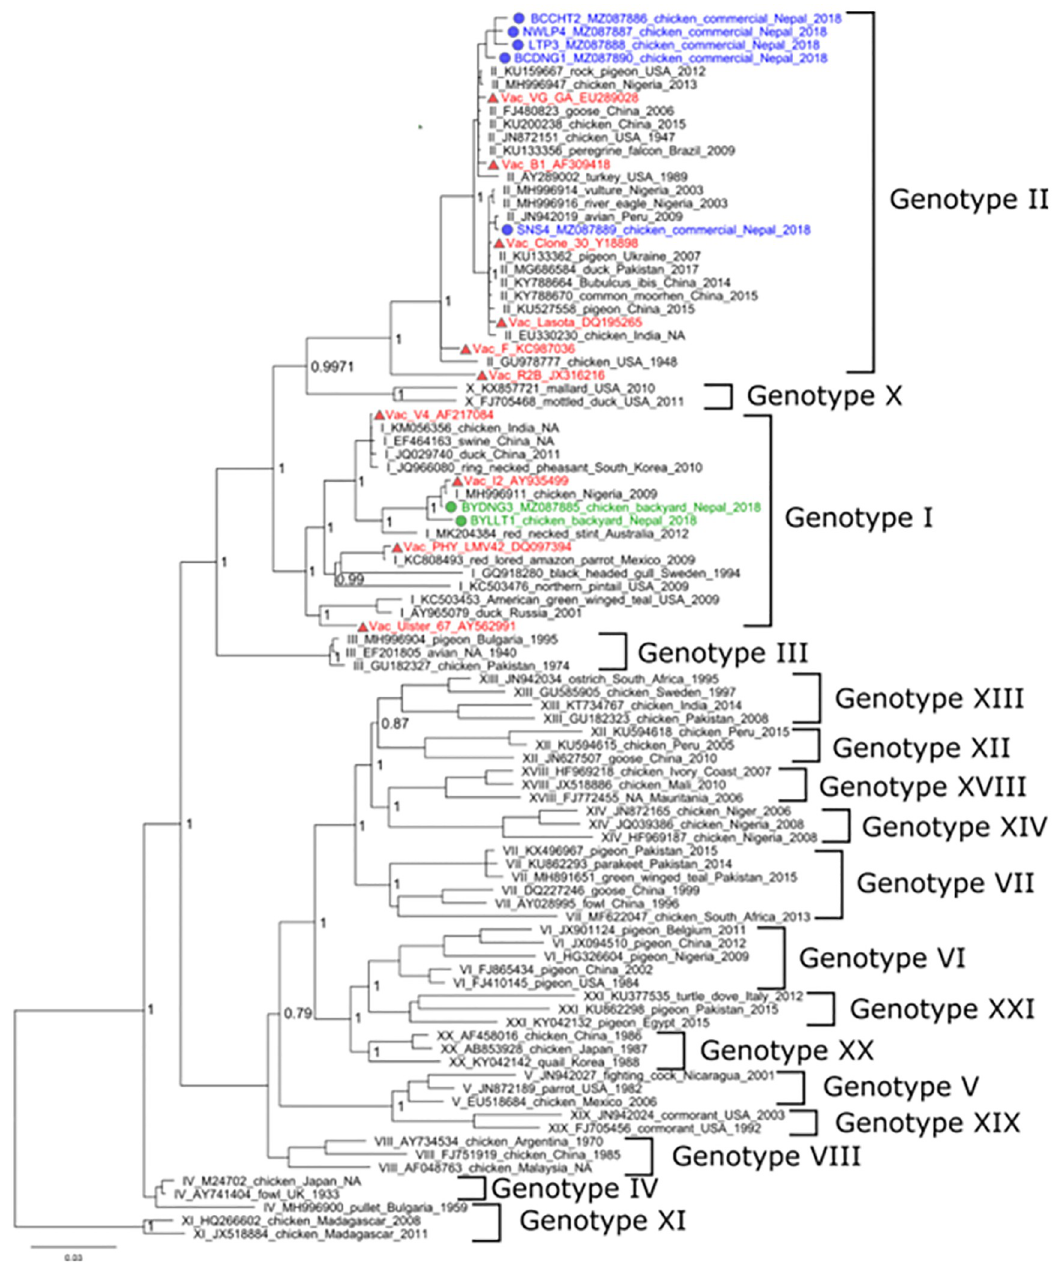
Fig 6. Phylogenetic analysis of the nucleotide sequences from the amplified products of NDV fusion genes (521 bp) for commercial and backyard chickens. A phylogenetic tree was constructed using a maximum likelihood in the IQTree with 1000 bootstrap replicates. The tree was viewed using Fig Tree V 1.4.4. NDV strains are represented in colors based on their detection source- commercial chickens (Blue), backyard chickens (green), vaccine strains (red) and the outbreak strain